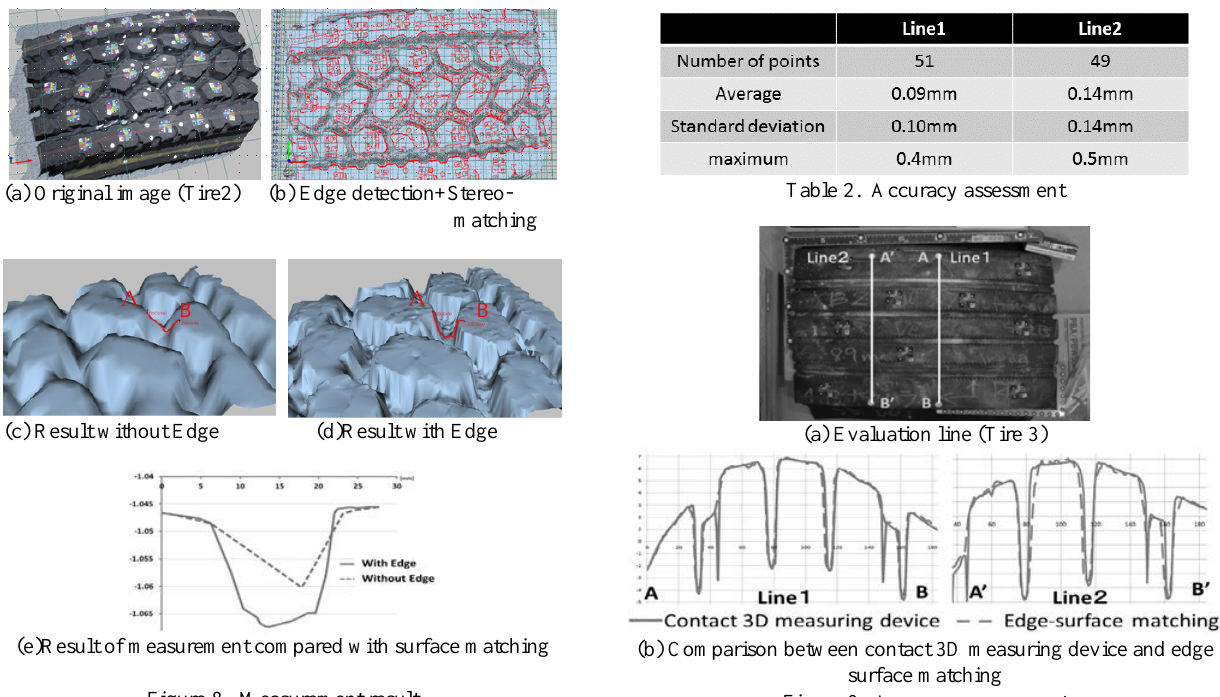
Figure 8. Measurement result Figure 9. Accuracy